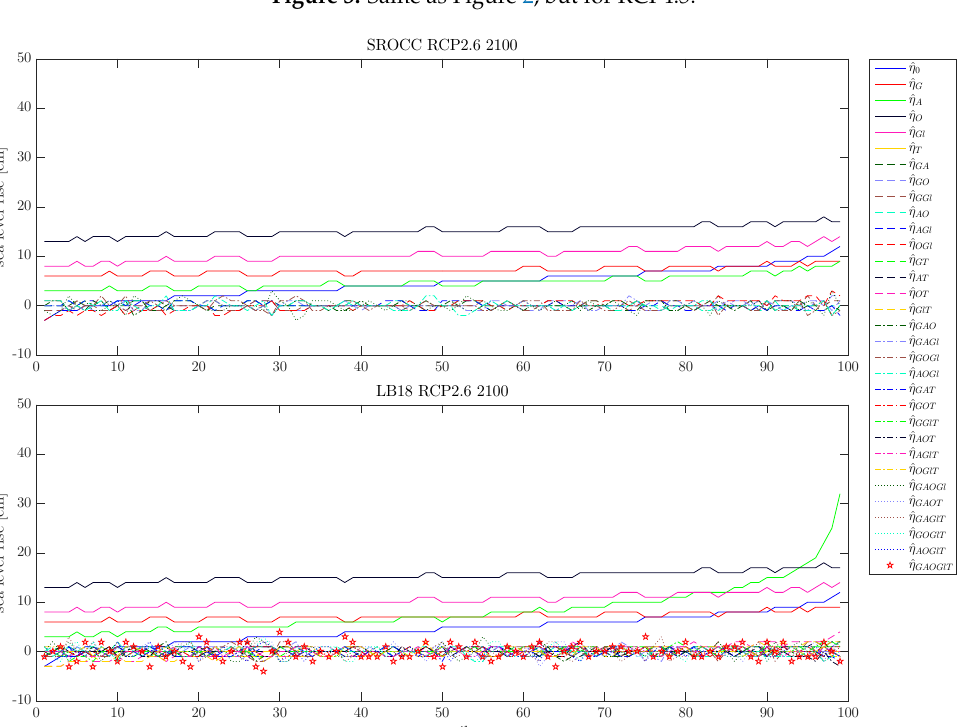
Figure 3. Same as Figure 2, but for RCP4.5.